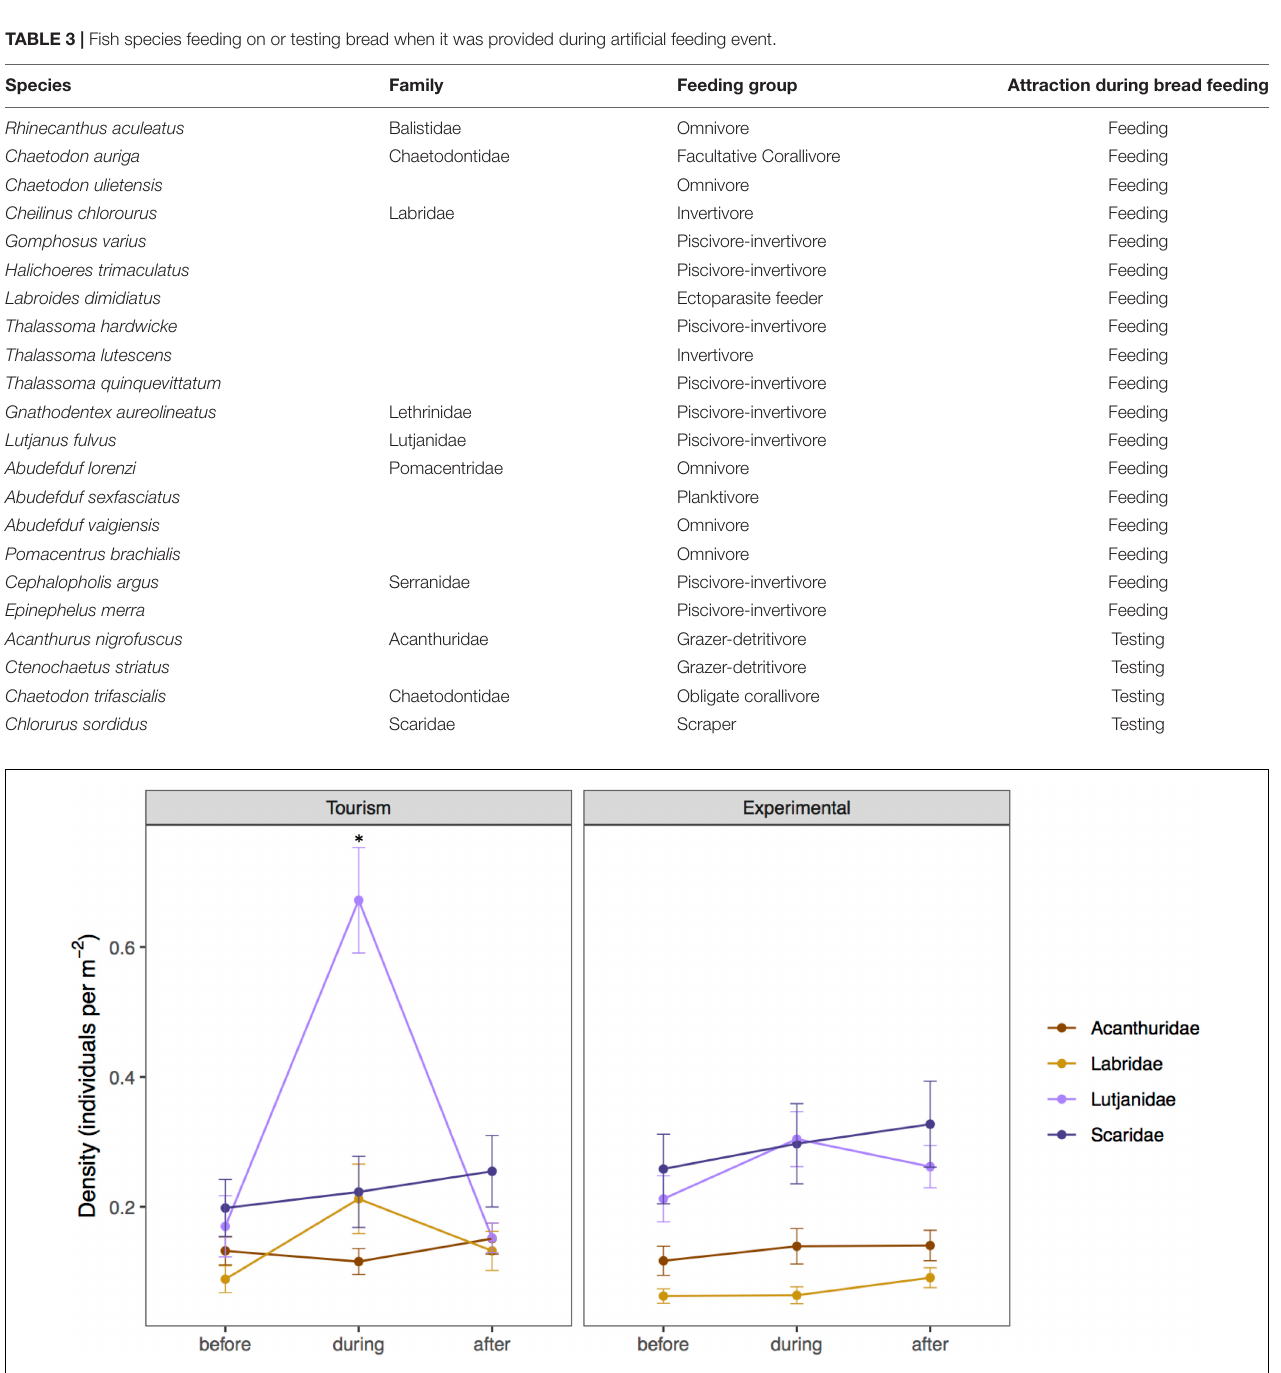
FIGURE 4 | Mean density ( ± SE) of the most ubiquitous species (grouped by family for graphical succinctness) before, during, and after bread feeding events at tourism and experimental feeding sites. Acanthuridae includes Ctenochaetus striatus , Acanthurus nigrofuscus , Naso lituratus , Labridae includes